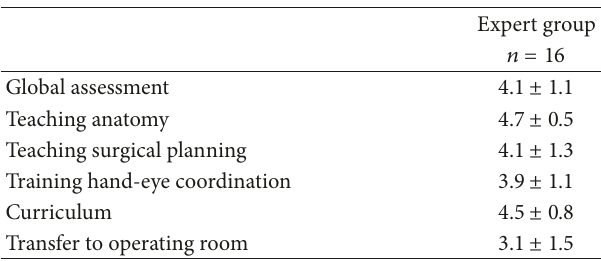
Table 3: Face validity. Table 4: Content validity.